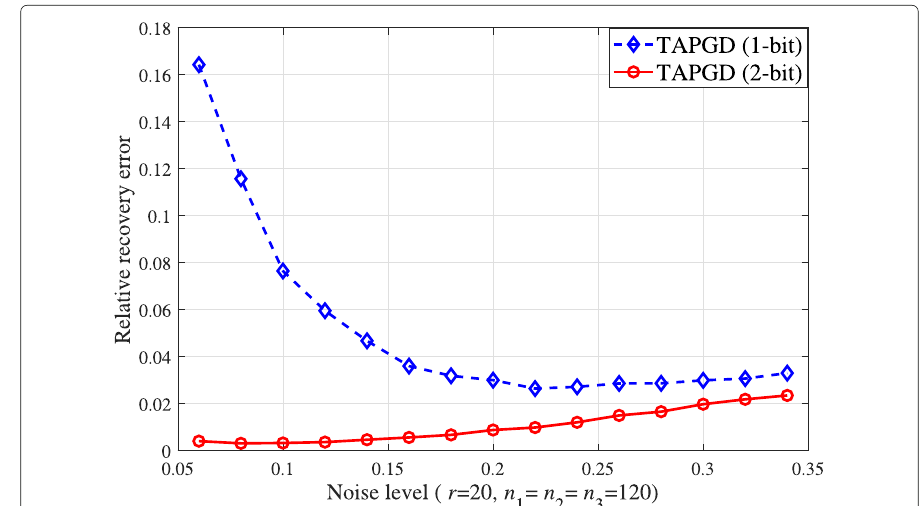
Fig. 4 Relative recovery error when noise level